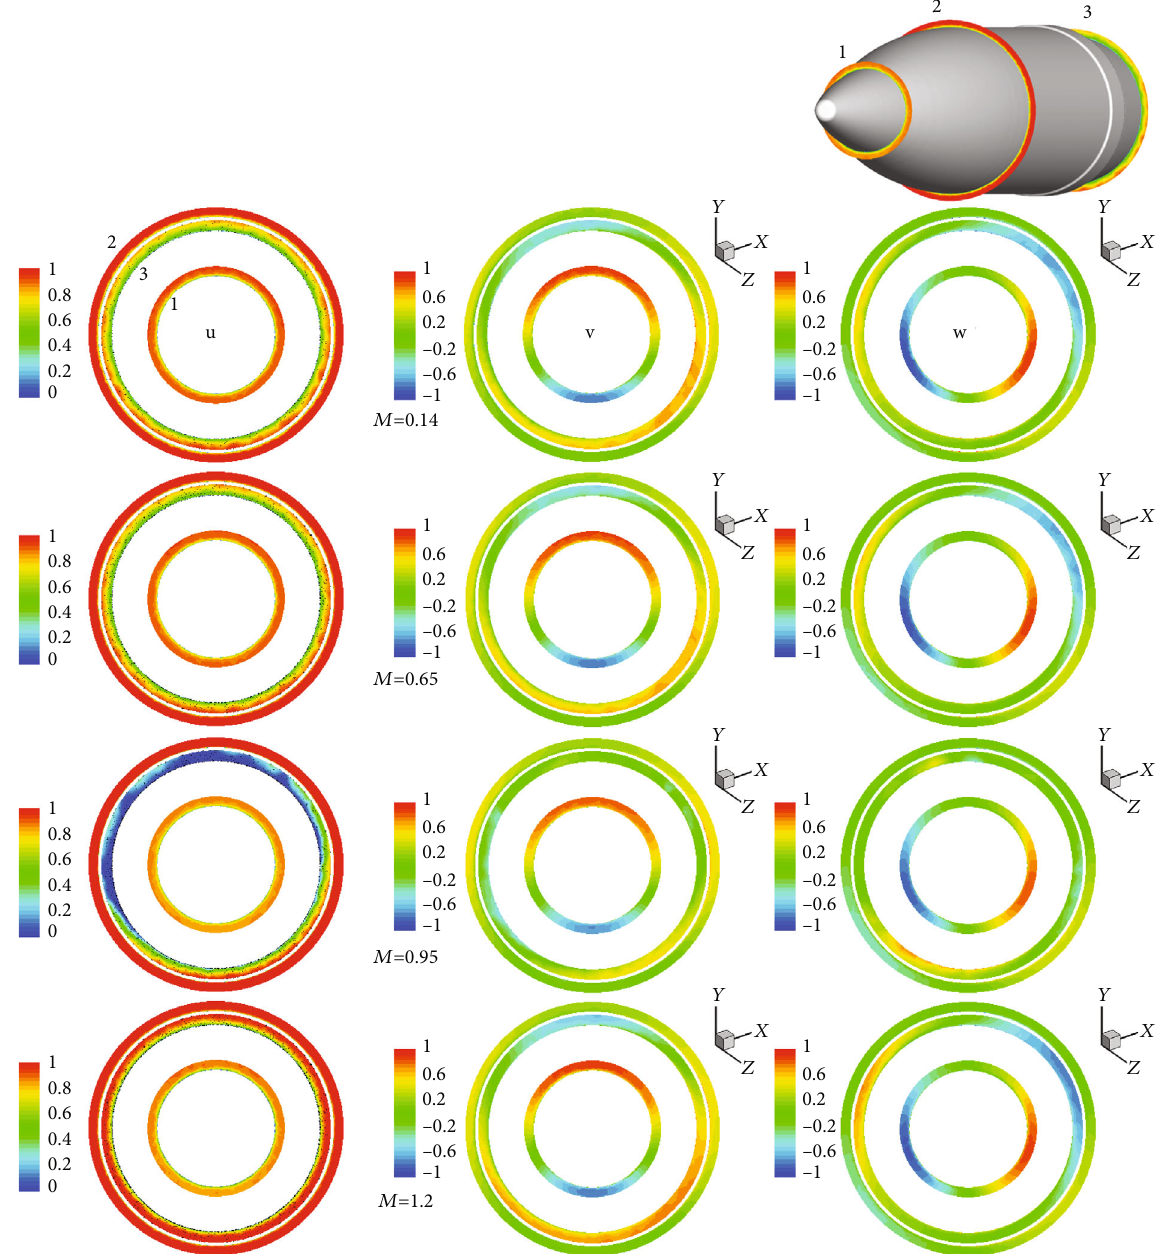
Figure 12: Contours of velocity components ( U , V , and W ) at three di ff erent positions (left) U -velocity in x -direction, (middle) V -velocity in y -direction, (right) W -velocity in z